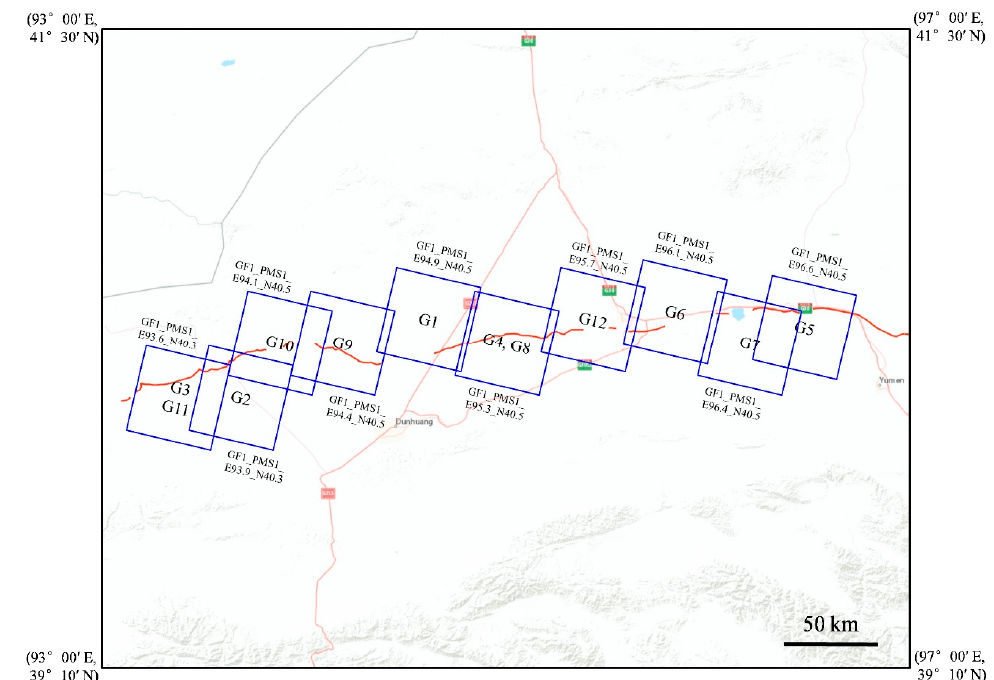
Figure 6. Spatial coverage of GF-1 PMS data in this study is shown by blue rectangles. The black numbers in the rectangles indicate the general location of 12 selected typical linear traces.